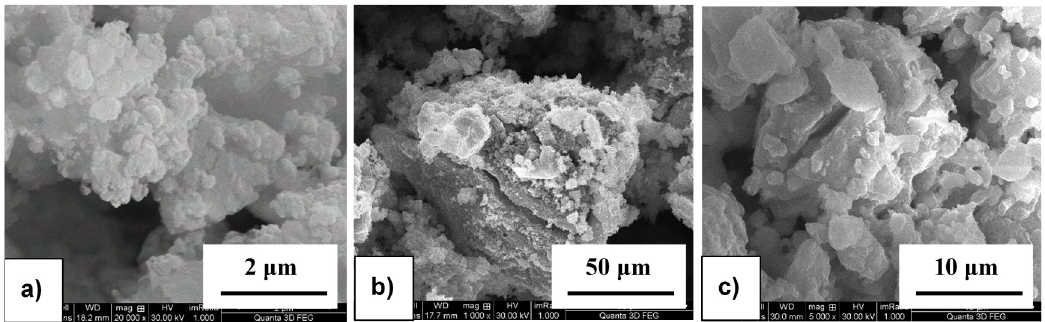
Figure 2. The morphology of the (2LiAlH 4 +CaCl 2 ) powders after varying time of milling: ( a ) 5 min; ( b ) 10 min; and ( c ) 5